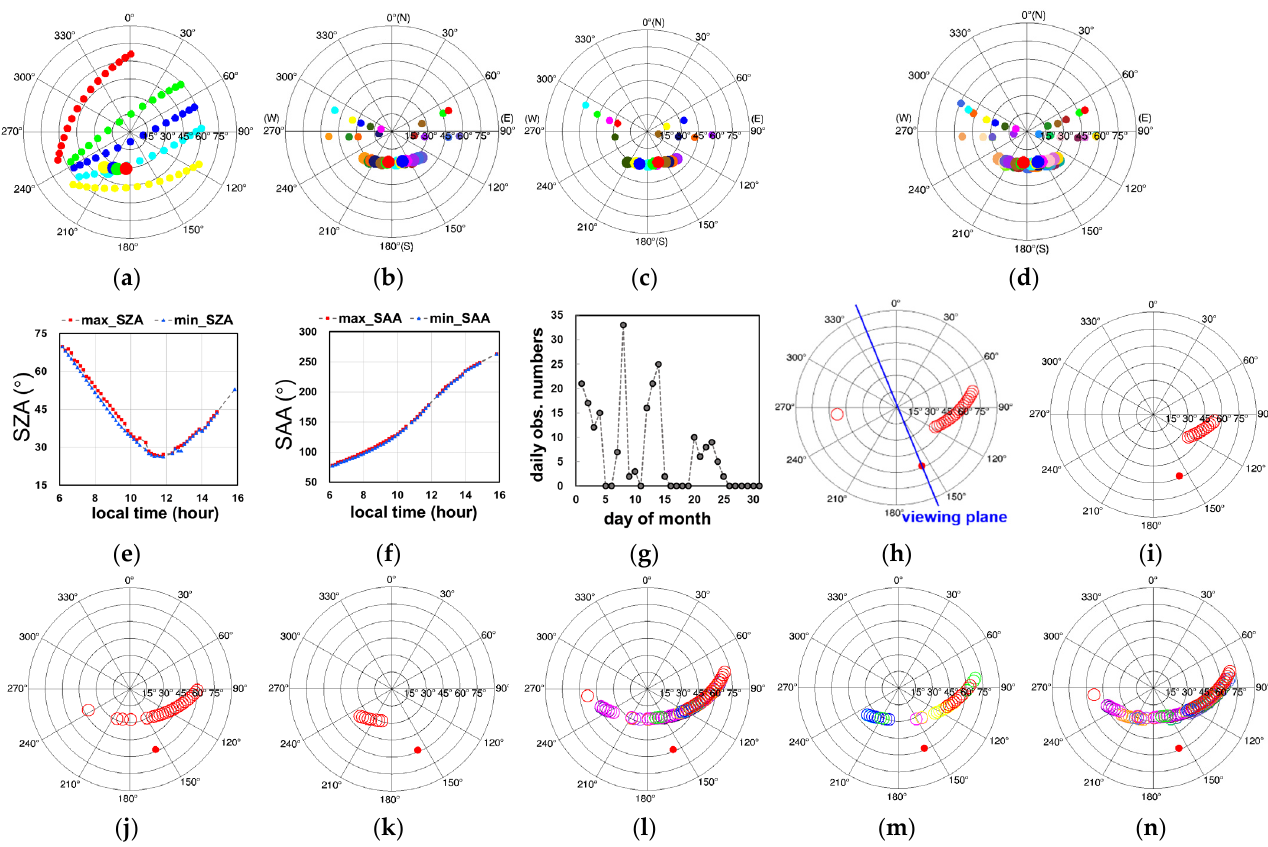
Figure 5. Statistics and distribution of the monthly accumulative sun-viewing angles for POLDER, MODIS, and AHI at a mixed forest pixel. The larger circles refer to the solar angles and the smaller circles refer to the viewing geometries. ( a ) refers to the angle distribution of POLDER in August 2008 and the colours indicate the different solar angles. ( b – d ) refer to the accumulated angles for MODIS for the first half of the month, the second half of the month, and the whole month in July 2020, respectively; the colours indicate the different solar angles. ( e , f ) present the ranges of SZA and SAA during July 2020. ( g ) presents the number of AHI observations for each day in July 2020. ( h – k ) refer to the accumulated angles for the AHI on four typical days, 1 July, 3 July, 14 July, and 22 July 2020, respectively. ( l – n ) refer to the accumulated angles for the AHI for the first half of the month, the second half of the month, and the whole month in July 2020, respectively, and the colours indicate the different observation